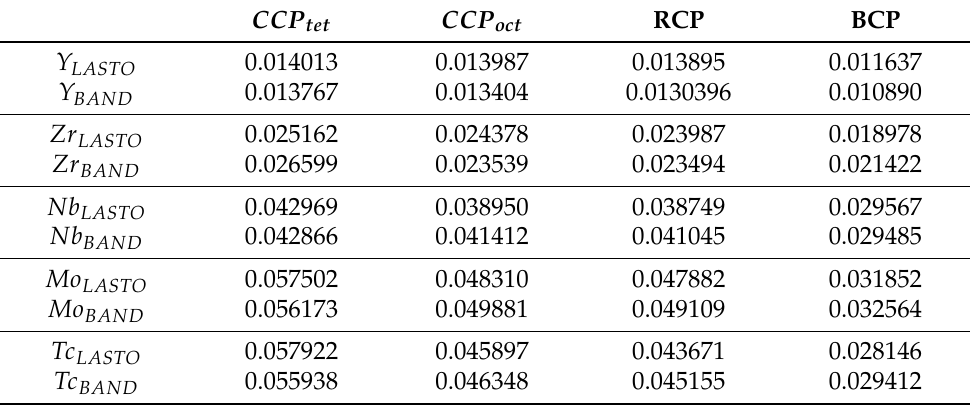
Table A1. Electron density values (a.u.) at critical points for selected FCC structures from LASTO and BAND results, as referenced in Figure 5. For comparison purposes, BAND results shown here were performed at the LASTO lattice constants, Table